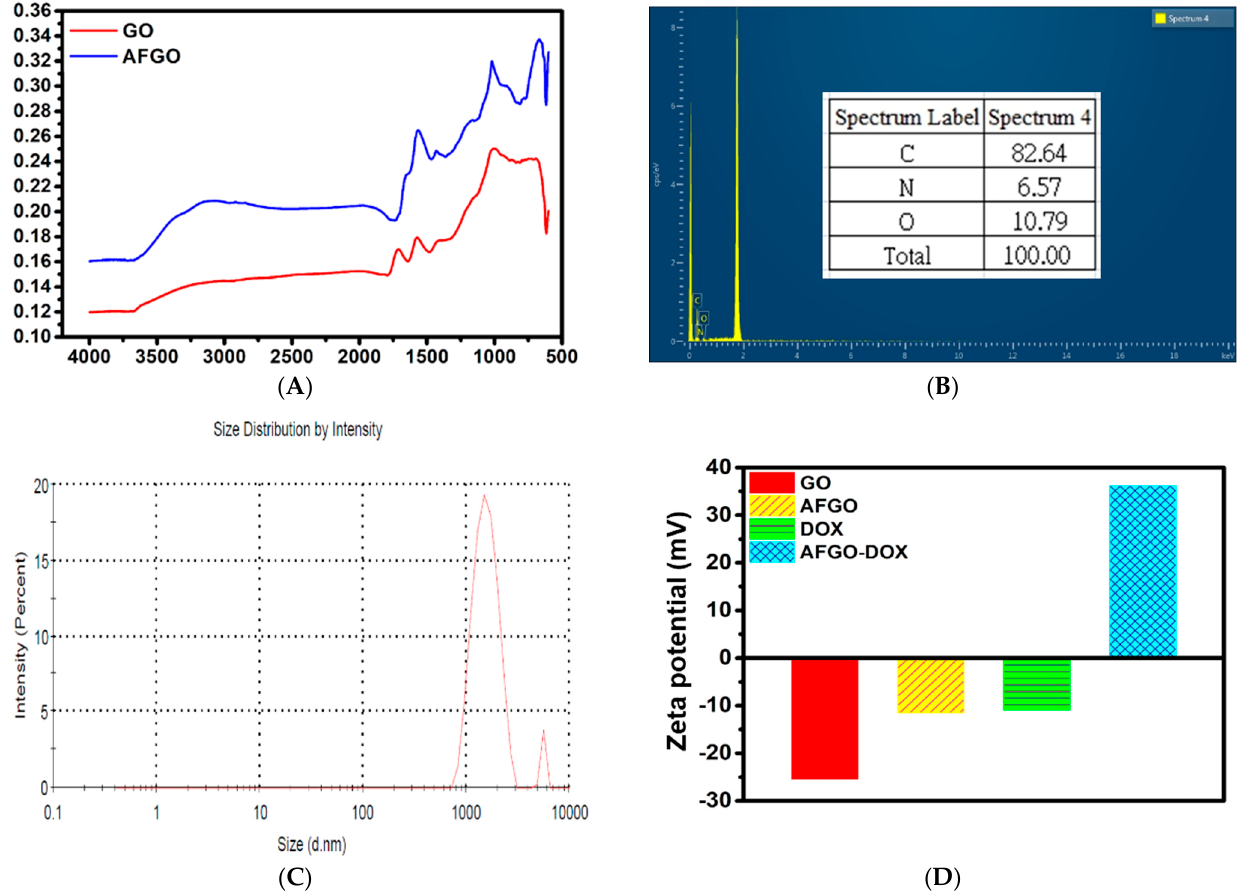
Figure 2. ( A ) FTIR spectrum of GO (red) and AFGO (blue). ( B ) EDS analysis of AFGO. ( C ) Size distribution of AFGO was evaluated using a laser diffraction particle size analyzer. ( D ) Zeta potentials of GO, AFGO, DOX and AFGO–DOX.